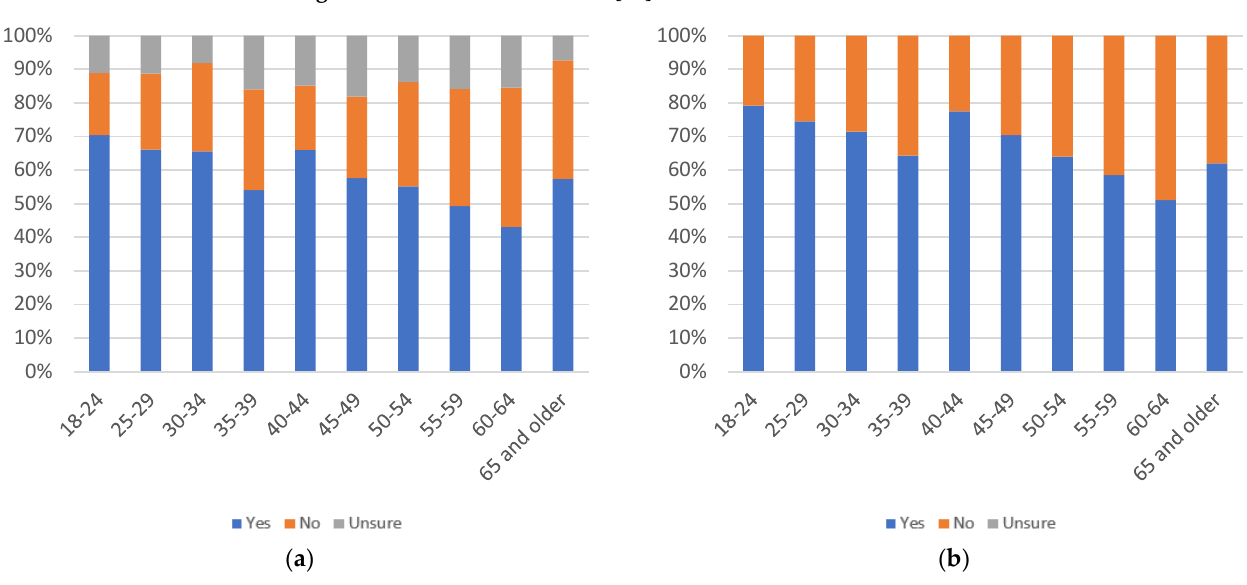
Figure 21. Label helpfulness, by age group: ( a ) with uncertain respondents (left) and ( b ) without uncertain respondents (right).